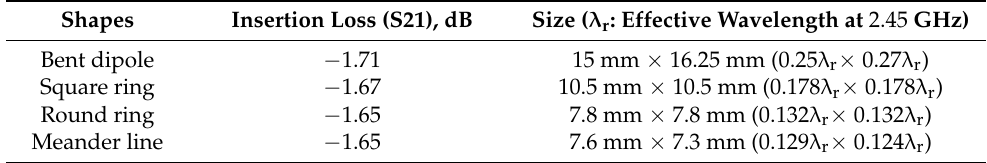
Table 1. Characteristics of narrowband resonators.